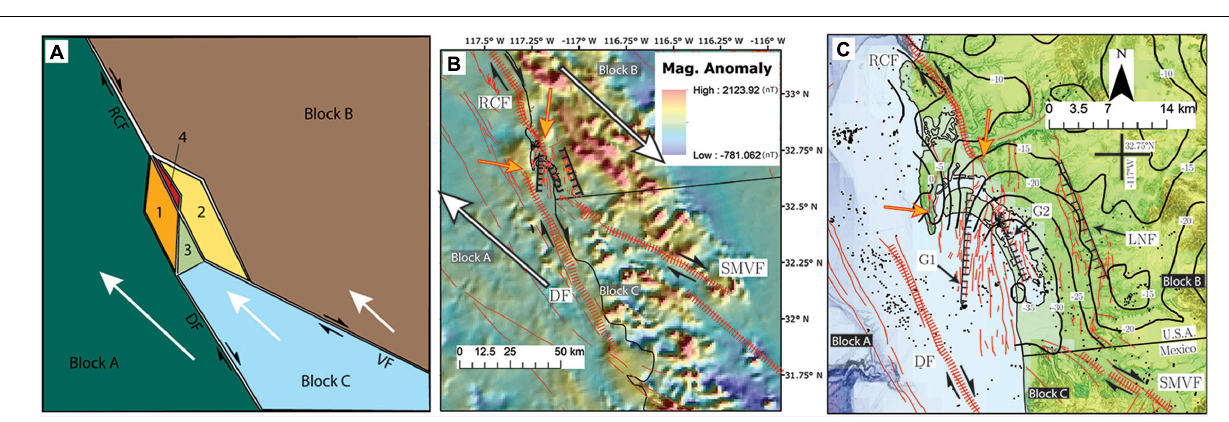
amount of apparent displacement southward (compared to its northern segment), while Fault D1 accommodates greater displacement northward (again compared to its southern